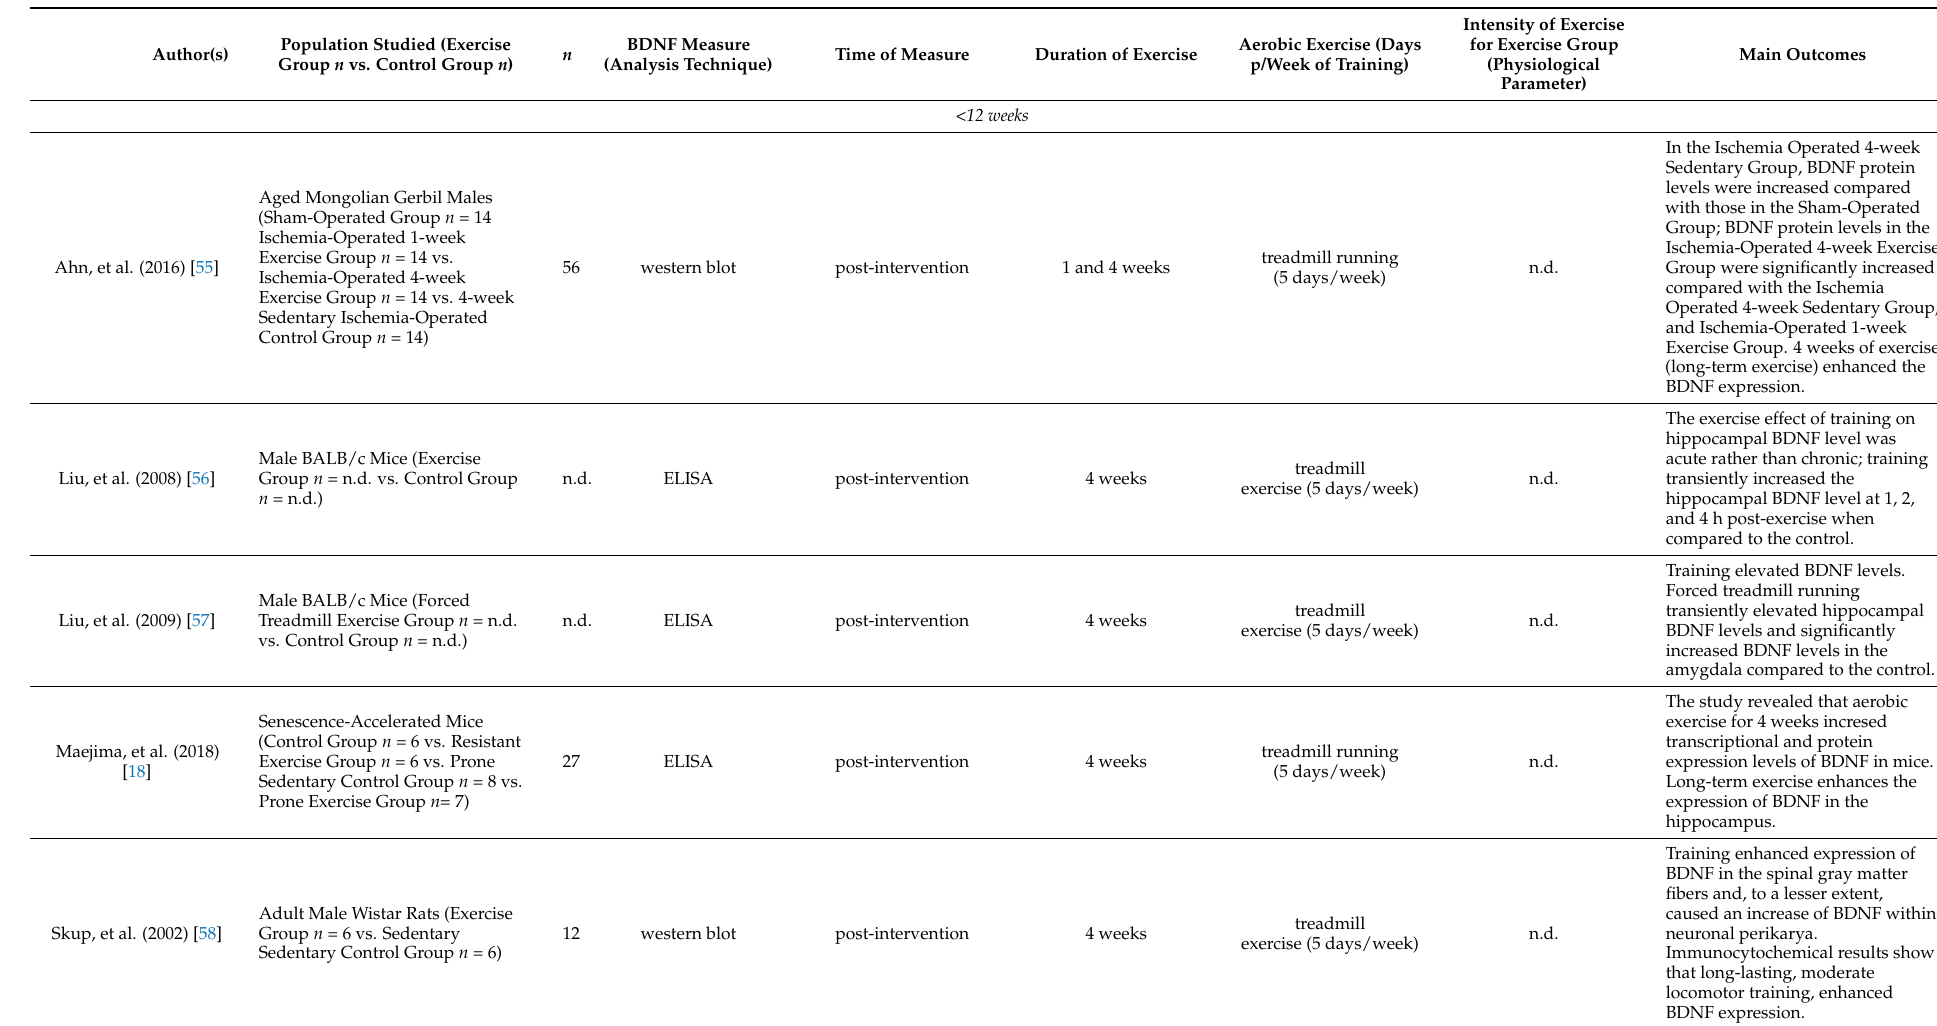
Table 2. Summary of studies that have reviewed the relationship between a chronic aerobic exercise intervention and the variation of BDNF blood concentration levels in animal models.